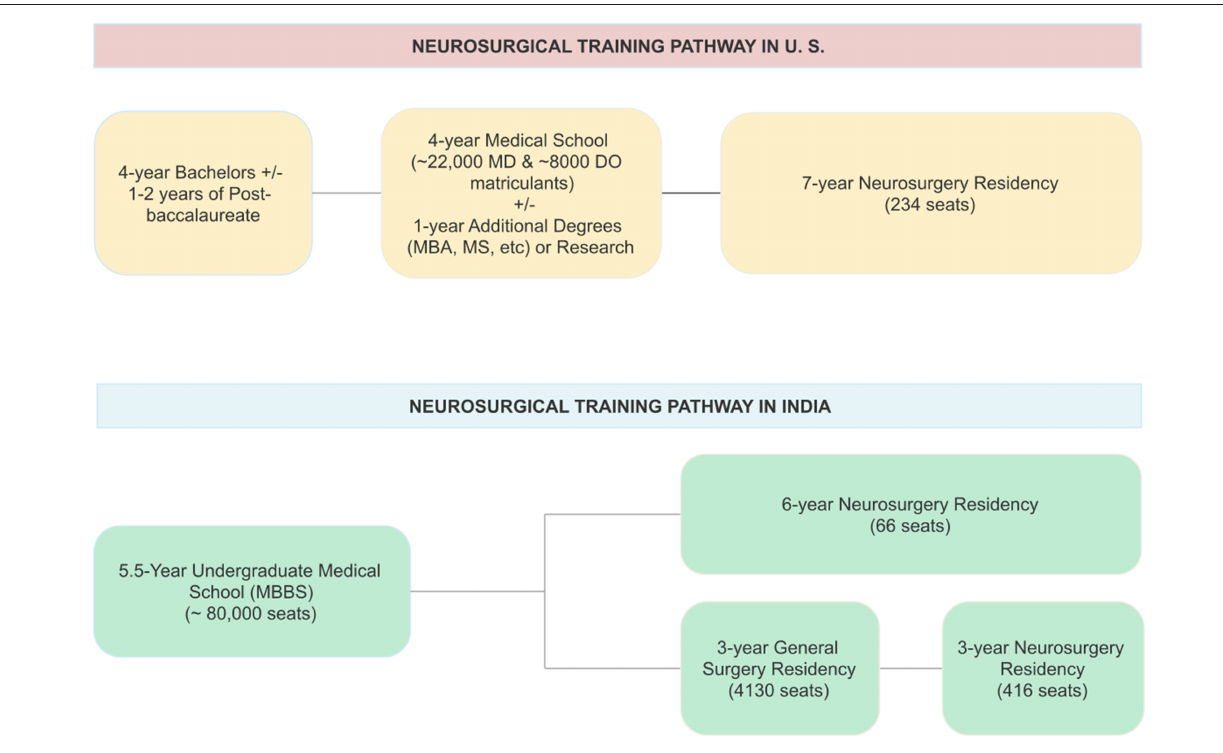
as uniformly poor (18). In the coexistence of both